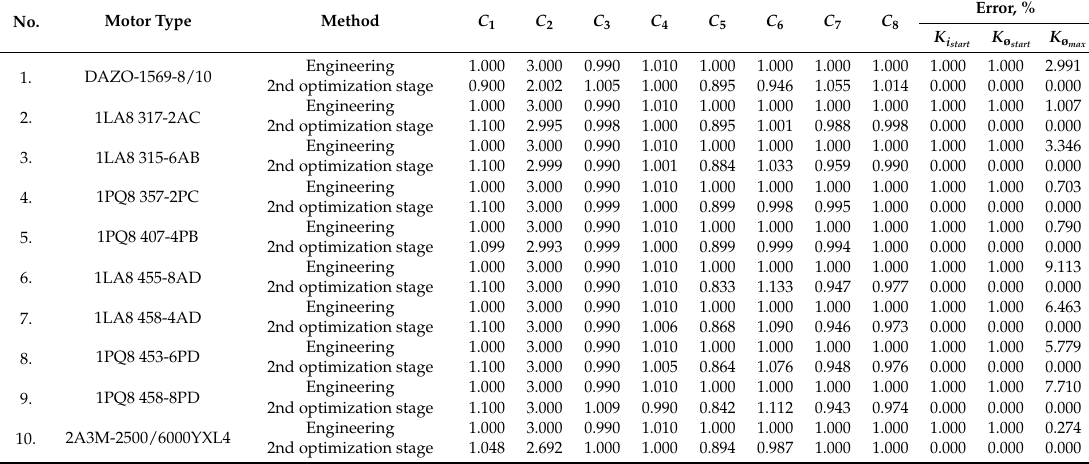
Table 3. Comparison between the results obtained by the engineering method and the 2nd optimization